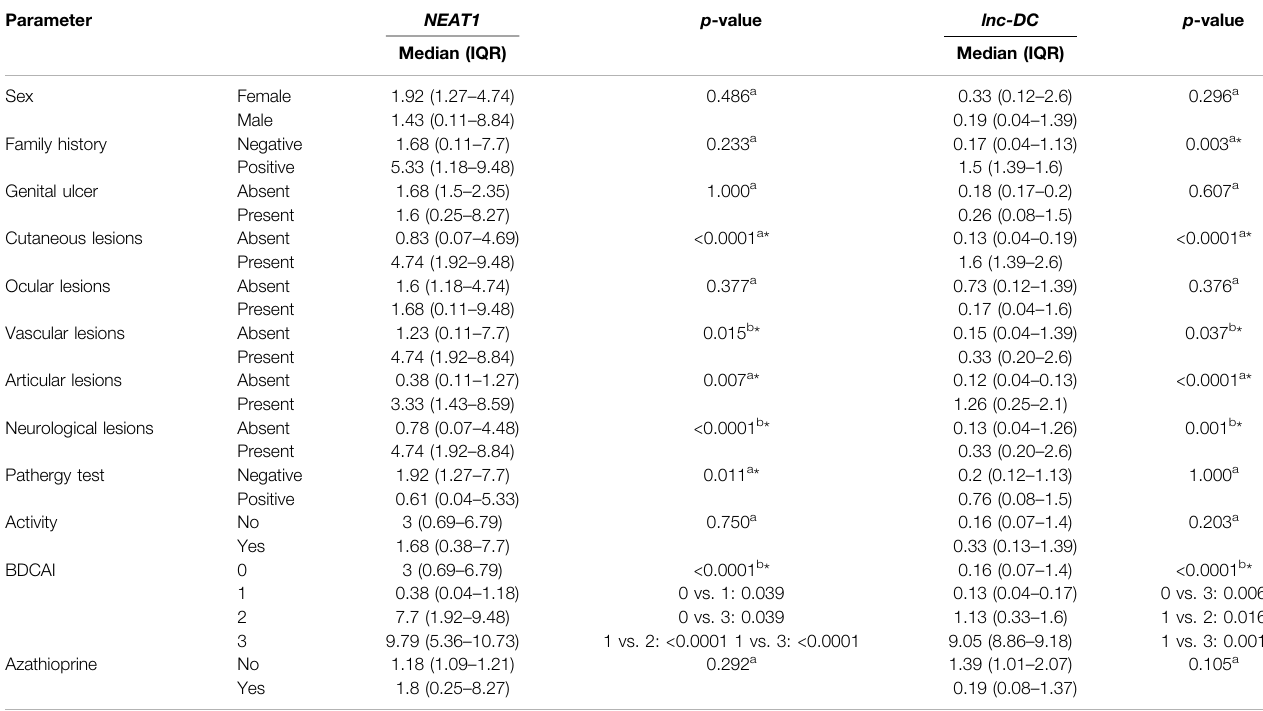
TABLE 3 | Gene expression in relation to demographic and clinical characteristics among cases.